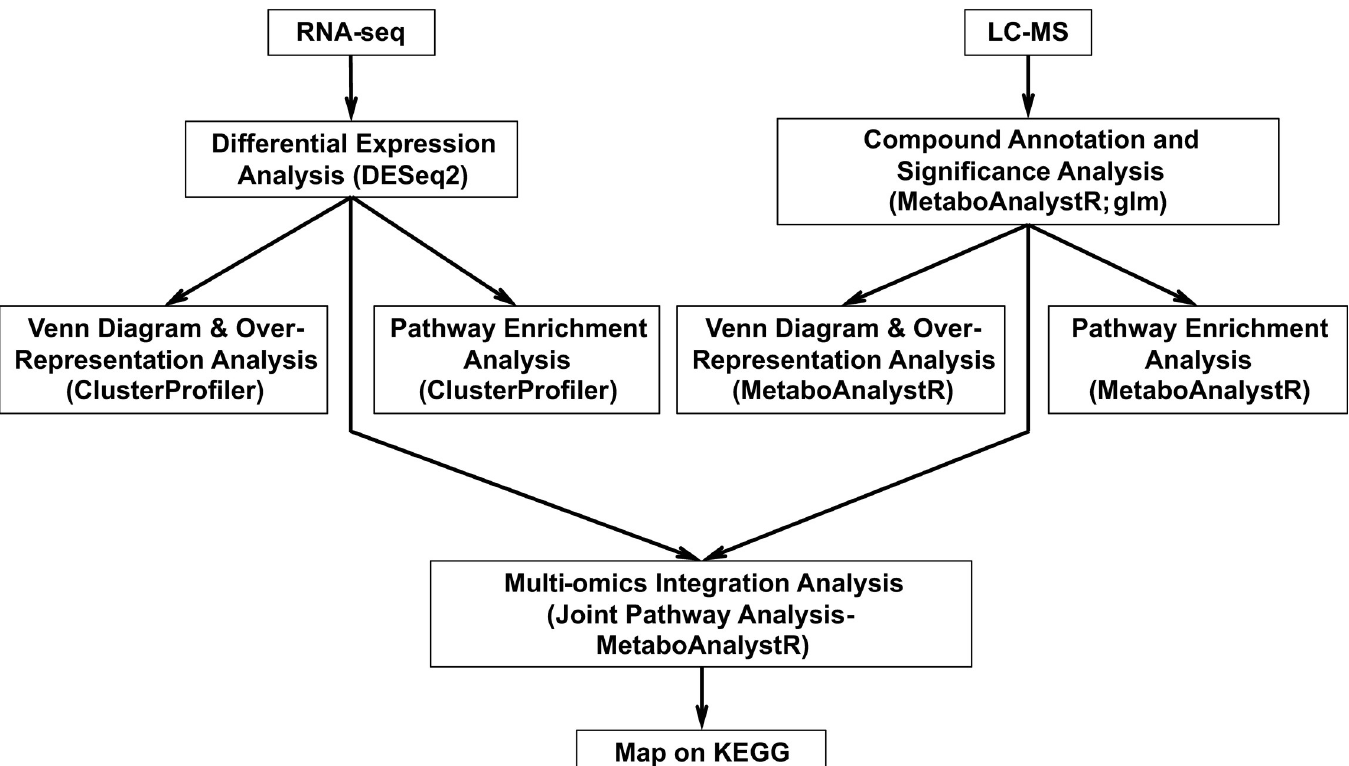
Fig 1. Analysis pipeline. Workflow of concentration analysis and sensitivity analysis for transcriptomics and metabolomics